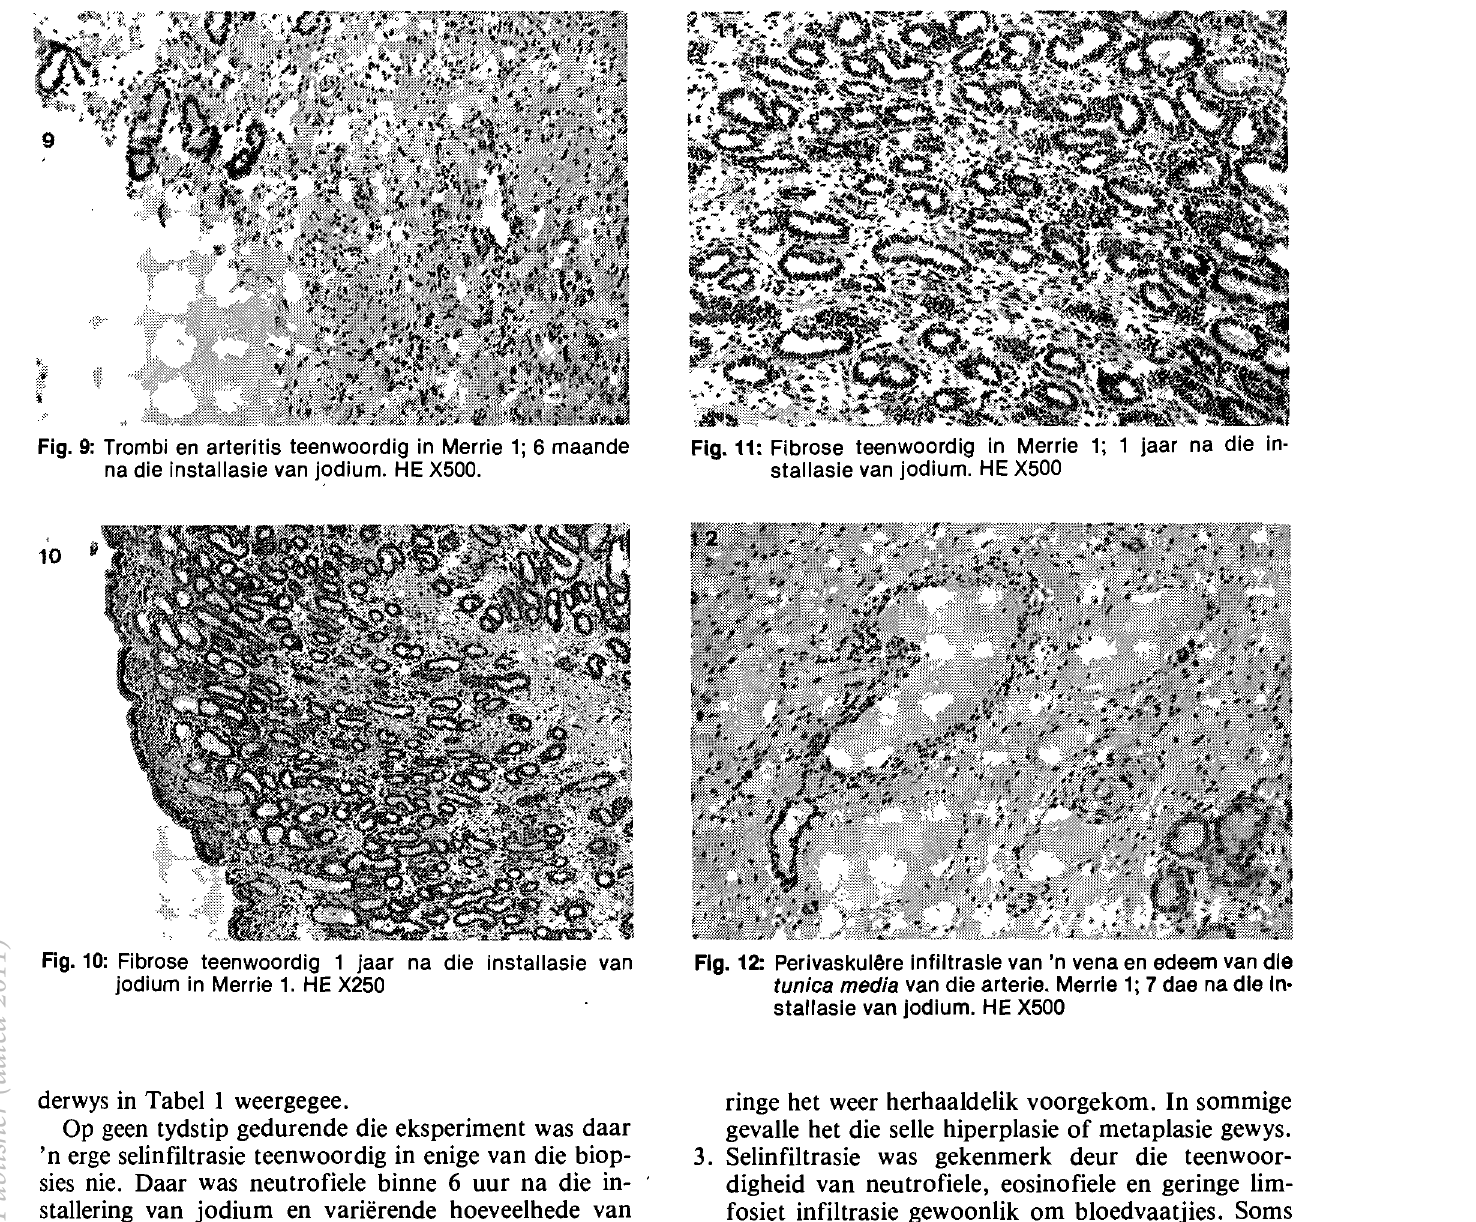
derwys in Tabel 1 weergegee.